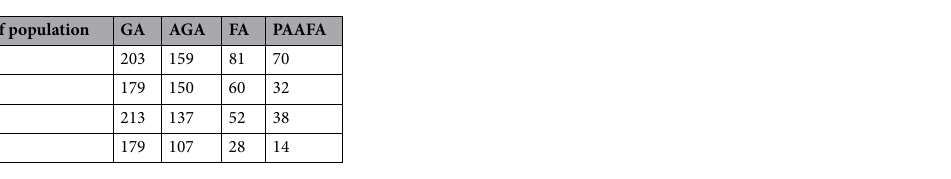
Table 1. Number of convergence iterations of the four algorithms for different population